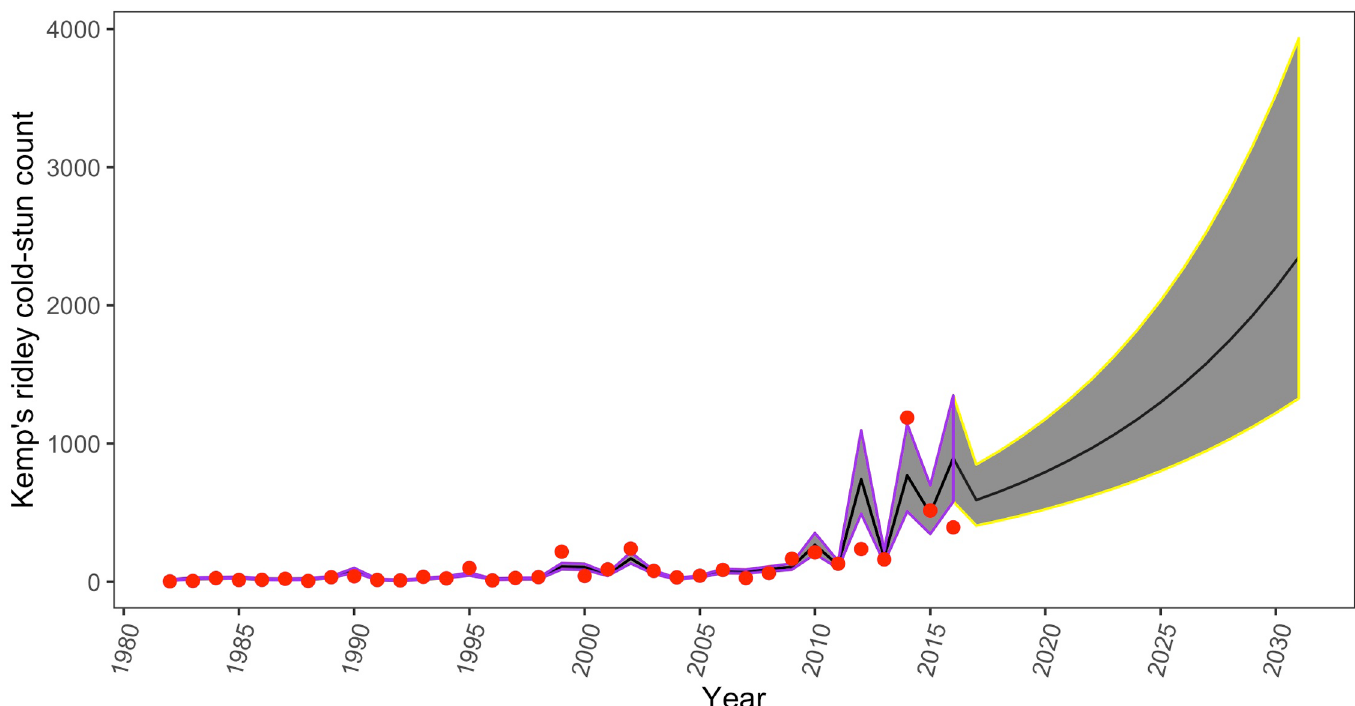
Fig 5. Observed and predicted Kemp’s ridley cold-stun count based on predicted future minimum of the daily mean SST (late October thru early November) within the study area.